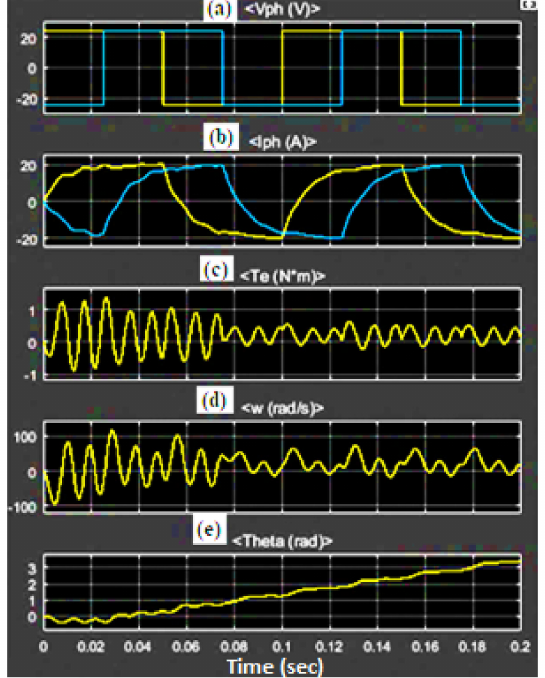
Figure 9. Results of the model in the Simulink libraries at T L = 0.2 Nm and period of time 0.1 s, ( a ) Va (yellow) Vb (blue), ( b ) Ia (yellow) Ib (blue), ( c ) electromagnetic torque, ( d ) speed, and ( e ) displacement angle.